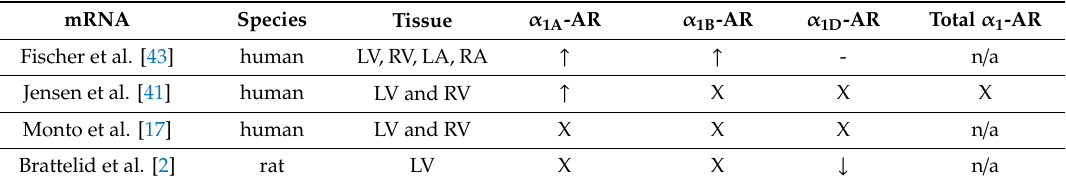
Table 1. Summary of the changes in cardiac mRNA studies for total α 1 -adrenoceptors (AR) and their subtypes in chronic heart